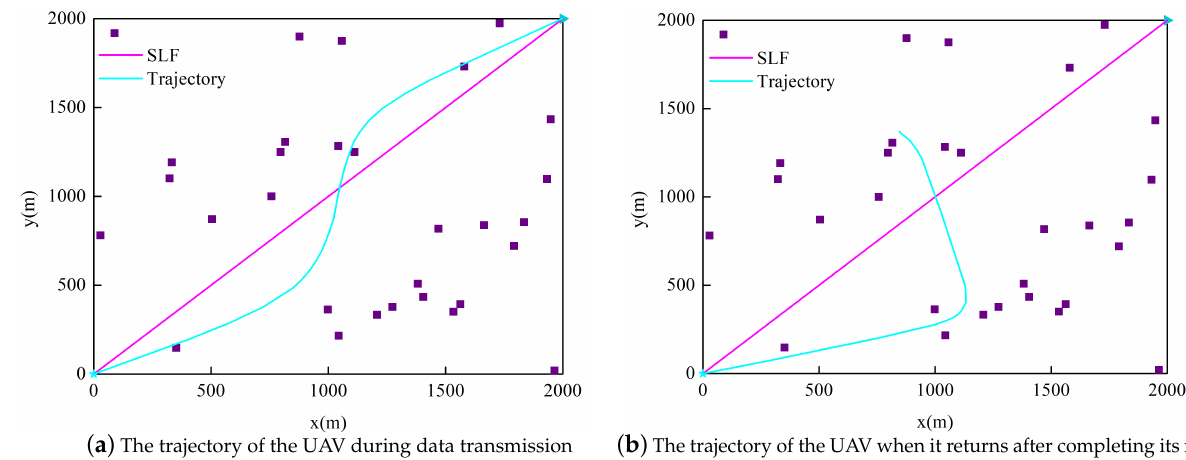
Figure 10. UAV trajectory in a large-scale scenario.